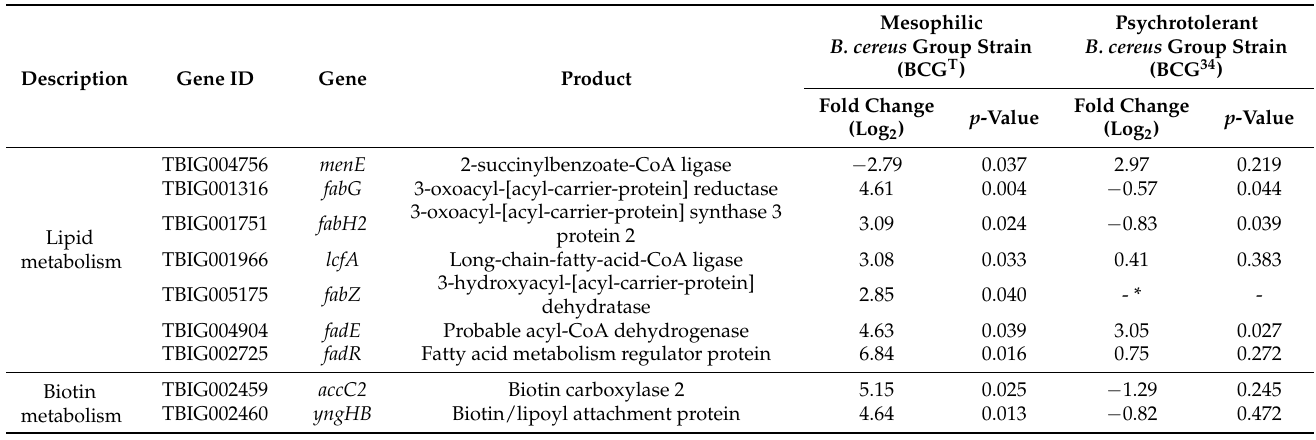
Table 3. Differential gene expression related to lipid metabolism of the mesophilic B. cereus group strain (BCG T ) and the psychrotolerant B. cereus group strain (BCG 34 ) grown at 10 ◦ C compared to growth at 30 ◦ C.